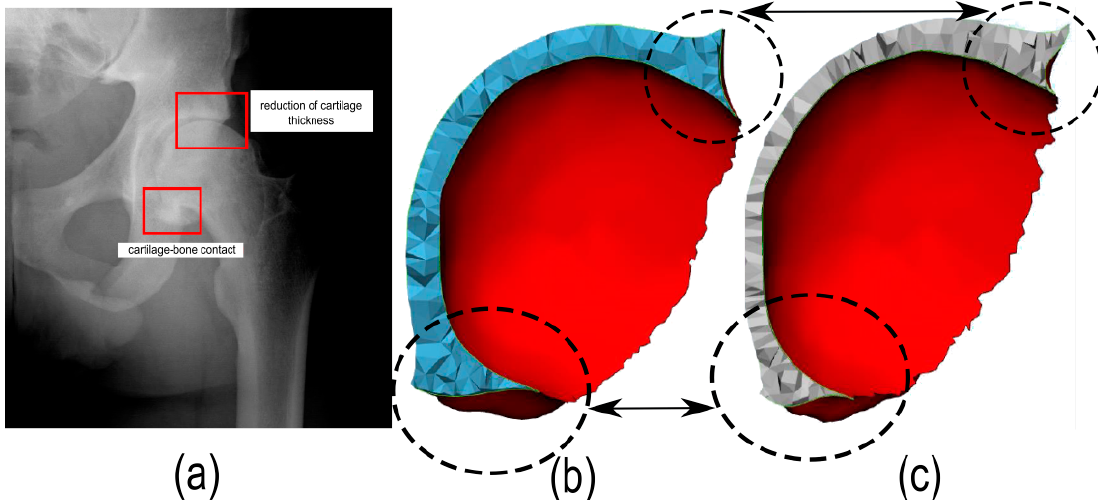
Figure 4. Reduction of the cartilage: ( a ) radiograph of the patient at age 27, ( b ) masks obtained for the patient’s healthy cartilage and ( c ) masks obtained for the patient’s damaged cartilage.